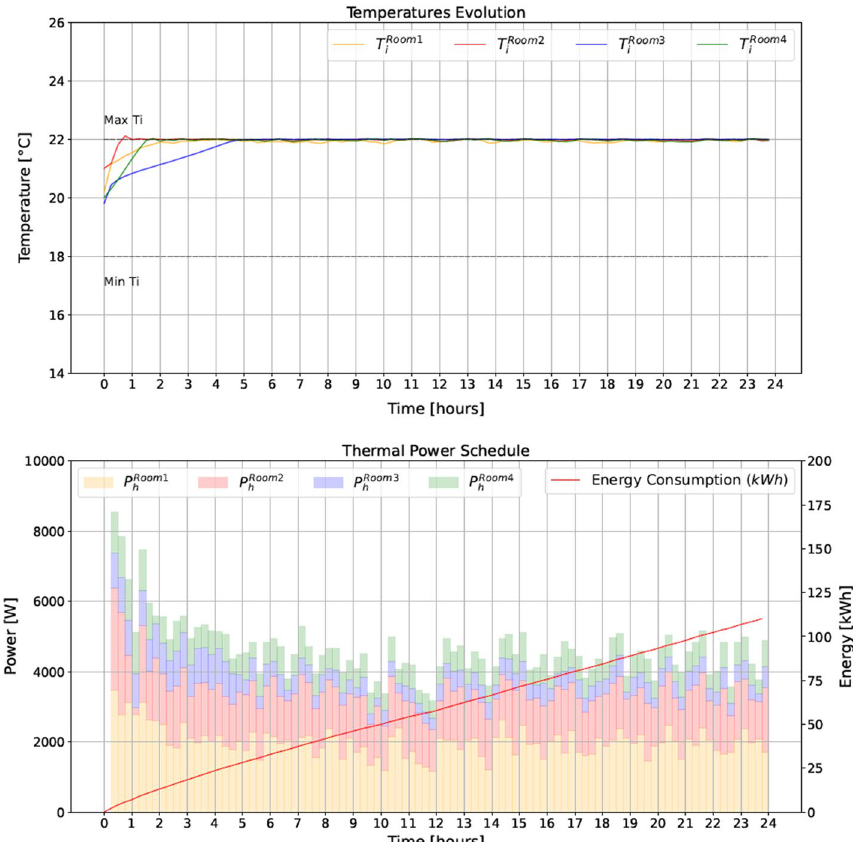
Fig. 9 The scenario of maximum energy consumption in terms of rooms’ temperature, power scheduling, and cumulative energy